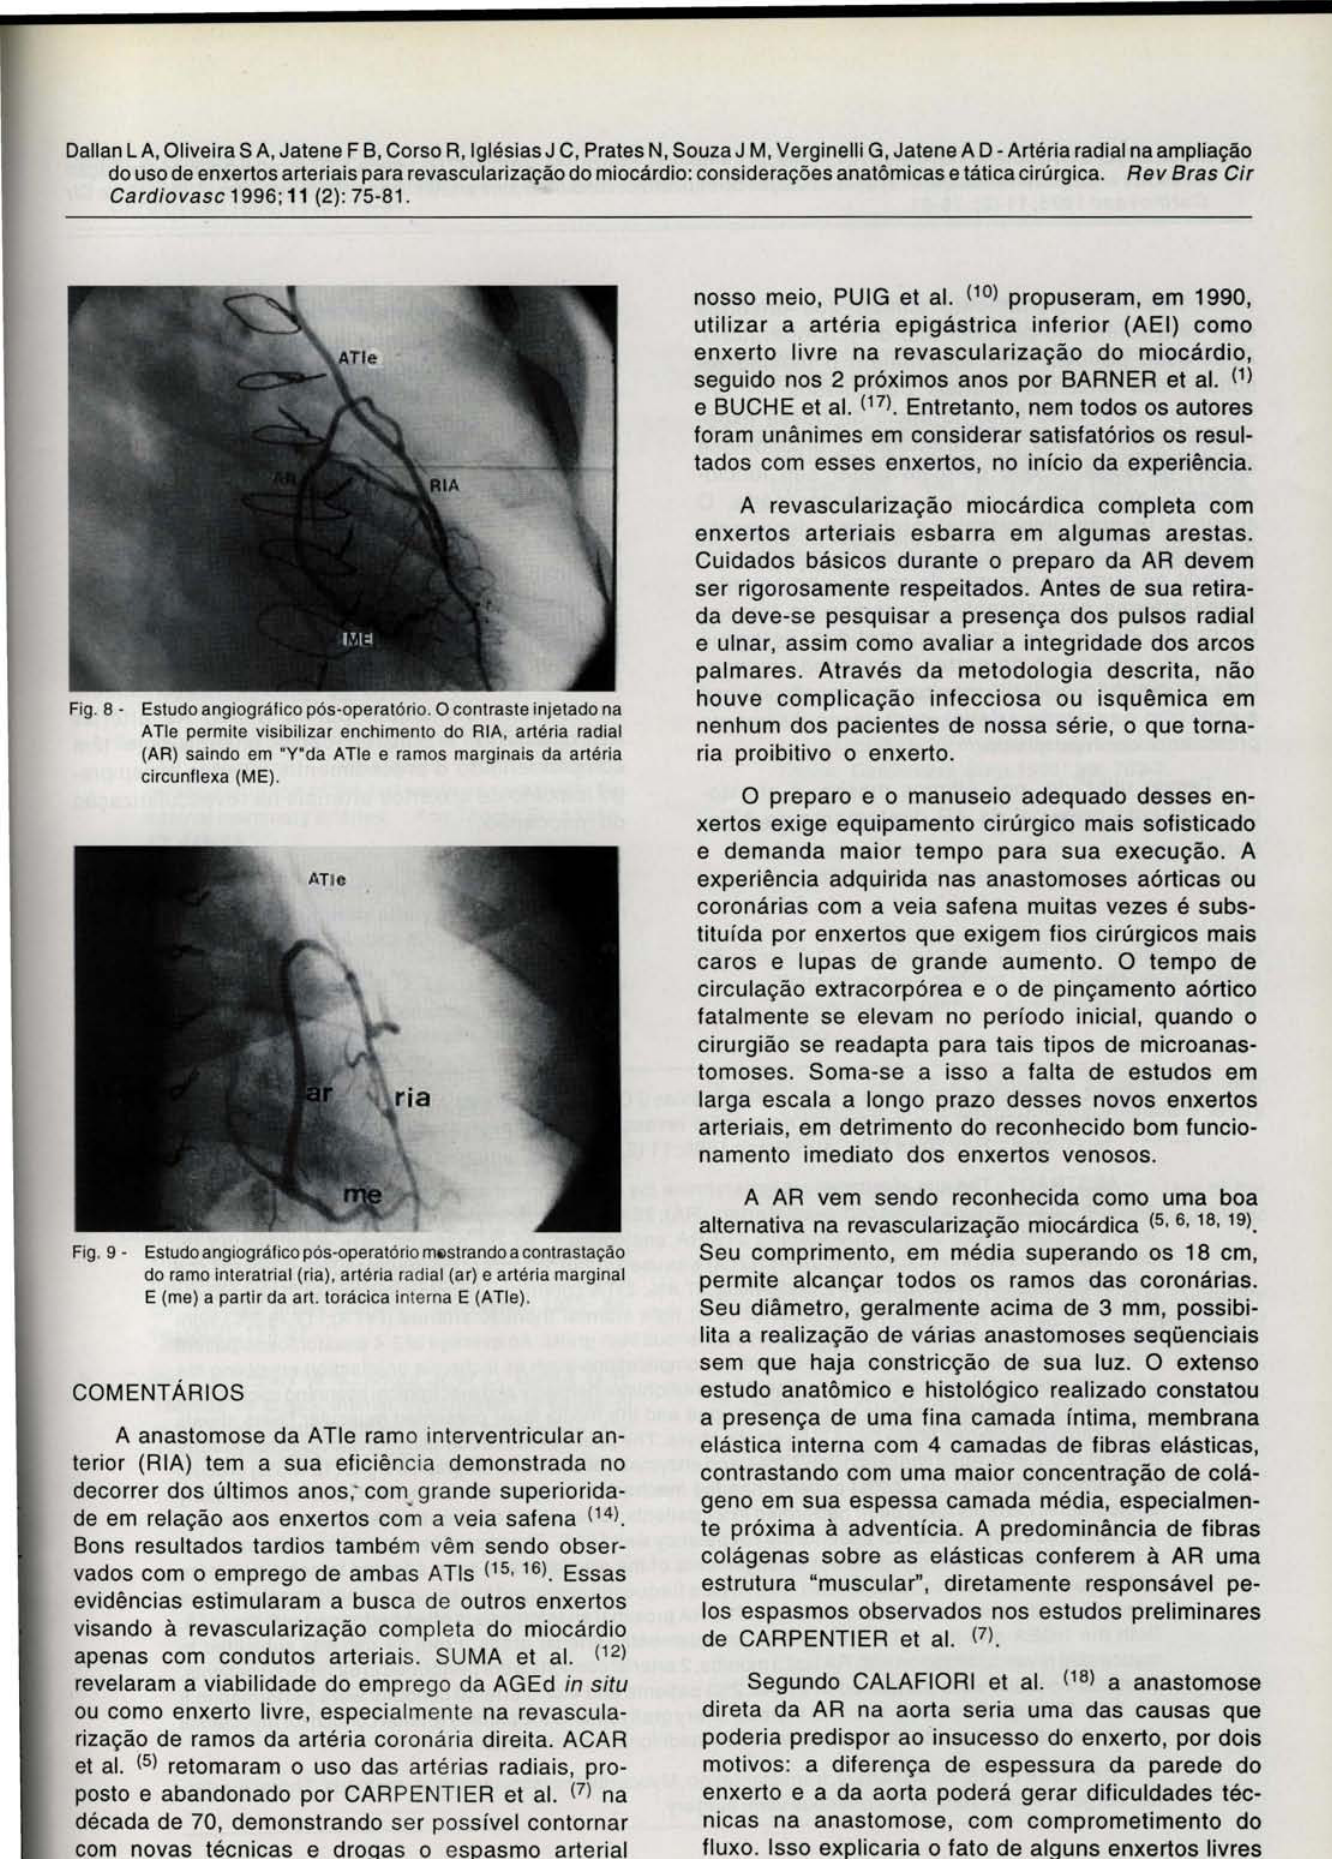
Fig. 8 - Estudo angiográfico pós-operatório. O contraste injetado na ATle permite visibilizar enchimento do RIA, artéria radial (AR) saindo em "y 'da ATle e ramos marginais da artéria circunflexa (ME).